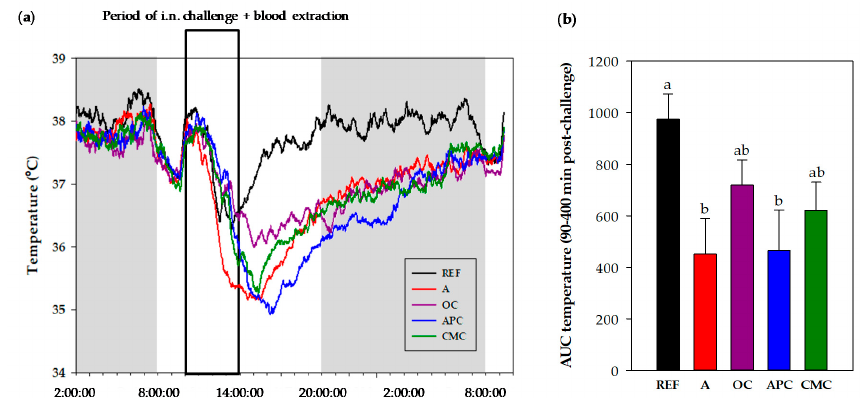
Figure 3. Changes in body temperature. Profile of body temperature from 2 a.m. before intranasal (i.n.) challenge and until 10 a.m the day after. Statistical di ff erences not shown ( a ). Area under the curve (AUC) of body temperature (from 34 °C) in the period comprised between 90 and 400 min after the i.n. challenge ( b ). REF: healthy animals fed standard diet; A: asthmatic animals fed standard diet; OC: asthmatic animals fed with ordinary cocoa-enriched diet; APC: asthmatic animals fed with “Amazonas Peru” cocoa-enriched diet; CMC: asthmatic animals fed with “Criollo de Montaña” cocoa-enriched diet. Results are shown as mean ( a ) or as mean plus standard error of the mean ( b ) ( N = 9). Values not sharing letters denote significant di ff erences between groups in ( b ) ( p < 0.01), while values sharing the same letter did not di ff er. Table 3. Temperature means at 2 h intervals from 2 h before until 18 h after the intranasal challenge. REF: healthy animals fed standard diet; A: asthmatic animals fed standard diet; OC: asthmatic animals fed with ordinary cocoa-enriched diet; APC: asthmatic animals fed with “Amazonas Peru” cocoa-enriched diet; CMC: asthmatic animals fed with “Criollo de Montaña” cocoa-enriched diet. Results are represented as mean ± standard error of the mean ( N = 9).